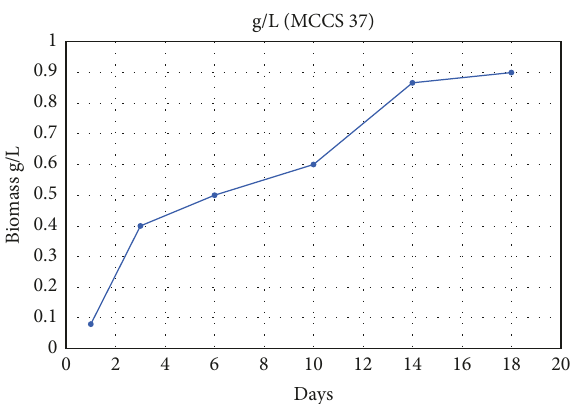
Figure 4: Growth curve of typical isolated microalgal strain (MCCS 37) from Kohgiluyeh and Boyer-Ahmad